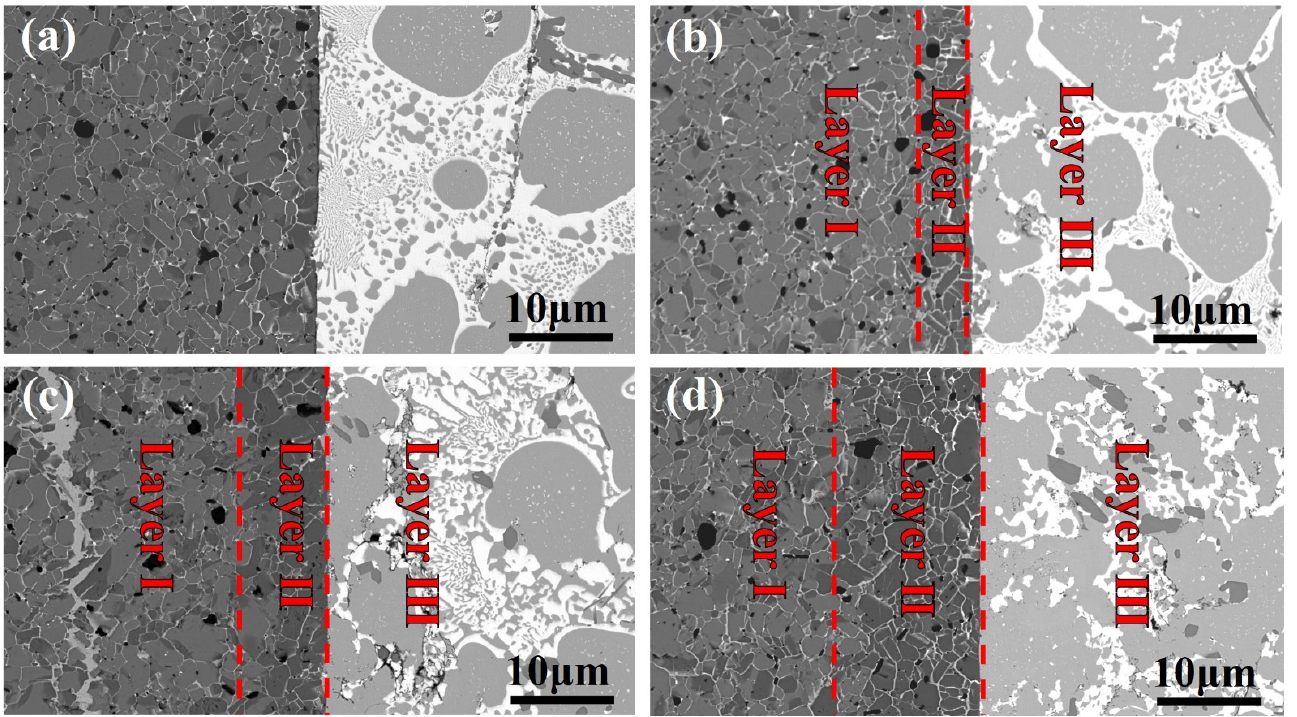
Figure 8. Effects of holding time on interfacial microstructure of Ti 3 SiC 2 /Ag-Cu-Ti+Cu mesh/Cu brazed joints: ( a ) t = 5 min, ( b ) t = 10 min, ( c ) t = 20 min, and ( d ) t = 30 min.